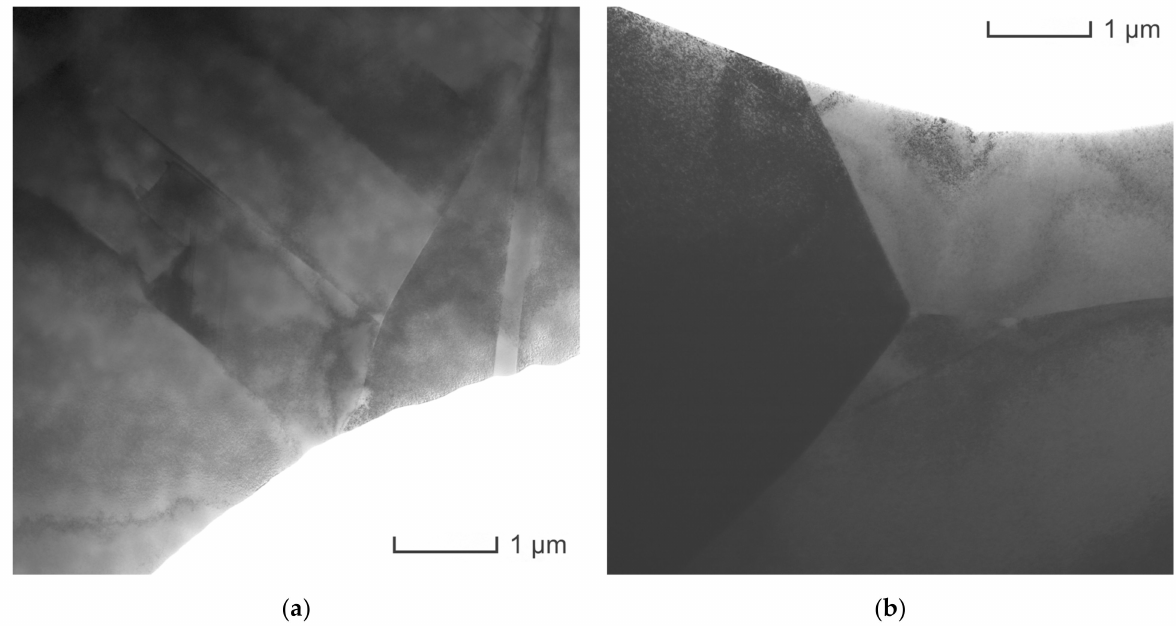
Figure 13. Two examples, ( a , b ), of TEM bright field images of the as-irradiated 65 dpa material in no particular two-beam condition, showing that any high density of dislocation lines expected of a cold-worked austenitic stainless steel, have all been removed by subsequent neutron irradiation. However, banded macrostructure remains from that initial cold-work.